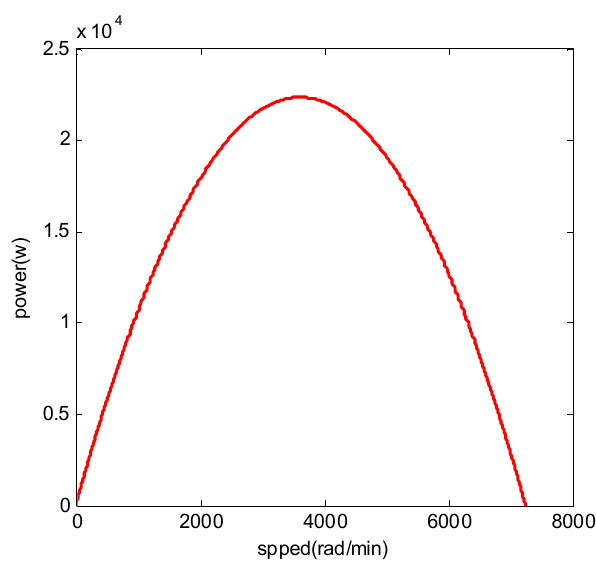
Figure 2. Speed and power curve of motor gear.